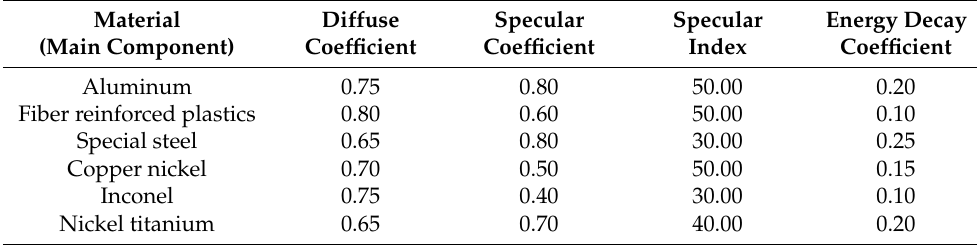
Table 2. Test material